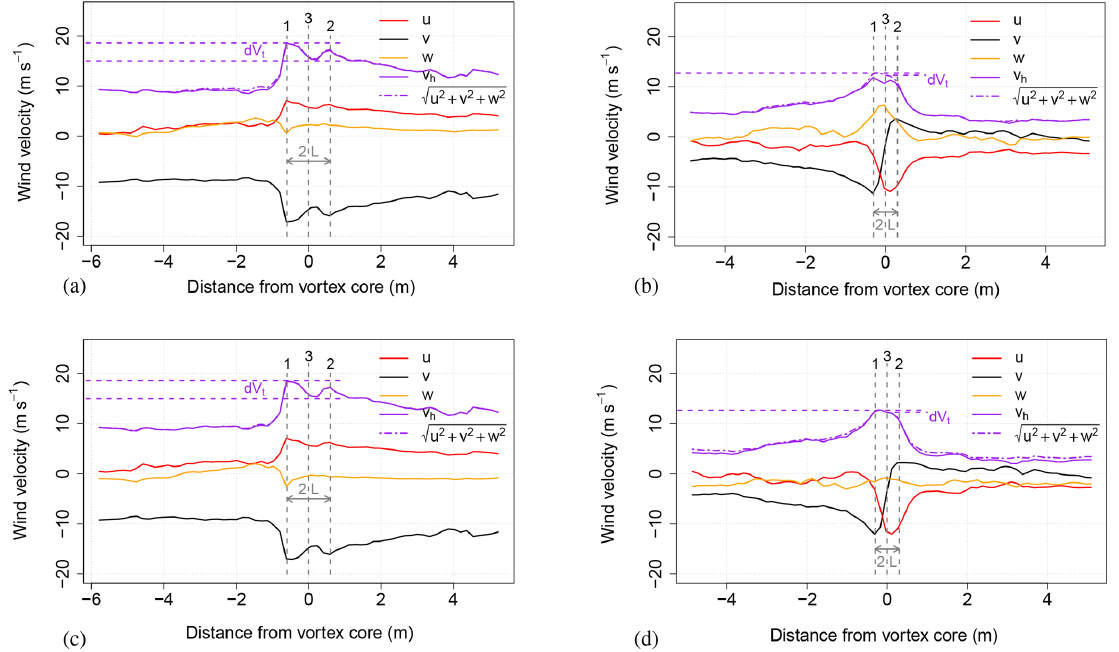
Figure 14. Measured tip vortex 1 and tip vortex 2 from Fig. 13a. Dashed purple lines indicate the velocity deficit (dent), dashed grey lines the peak-to-peak distance. The horizontal wind velocity v h is a superposition of the tangential velocity and the horizontal wind of the inflow/surroundings. To eliminate the w component, the data have been rotated into the vortex coordinate system. This is necessary to measure the vortex correctly. Panels (a) and (b) show the plain UAS measurement of the vortices. (c, d) The UAS has been rotated into the vortex coordinate system (vortex plane) to capture the whole two-dimensional